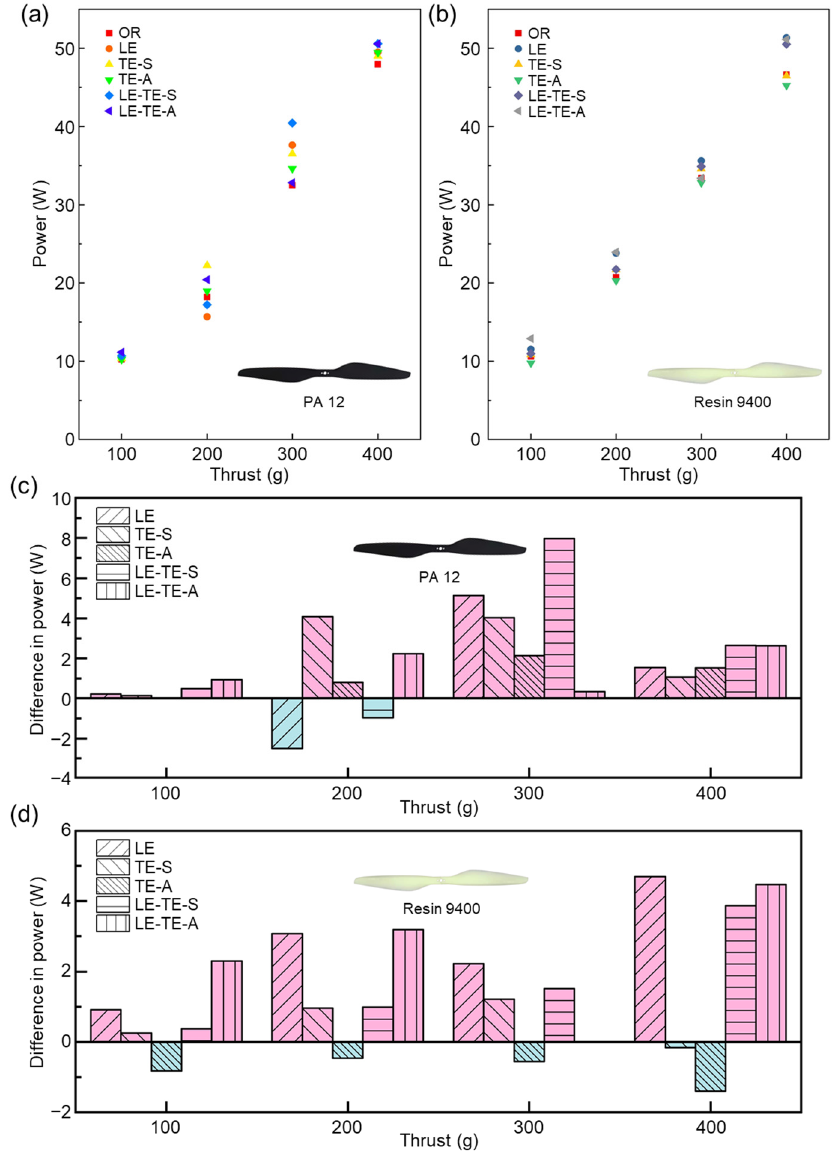
Figure 11. Power–thrust curves of different rotors. ( a ) Bionic rotors with PA 12; ( b ) Bionic rotors with Resin 9400; ( c ) Comparison of power consumption between bionic rotors with PA 12 under different thrusts; ( d ) Comparison of power consumption between bionic rotors with Resin 9400 under different thrusts. The power consumption of the OR rotor was taken as a reference value of (0 W). Under the same thrust, the increase in power was positive and the decrease in power was negative.